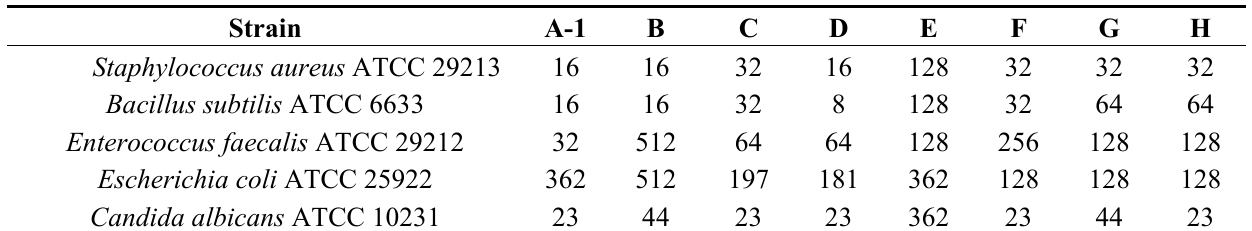
1. Assays 1 and 2: minimum inhibitory concentrations (MICs) of β -nitrostyrene